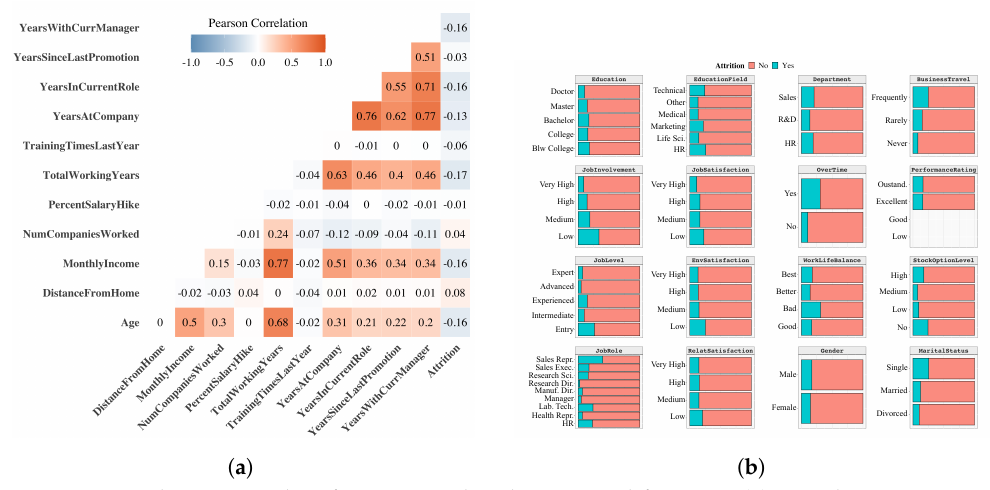
Figure 2. Exploratory analysisfor numerical and categorical features. ( a ) Correlation matrix of numerical features. ( b ) Barplots of categorical features by